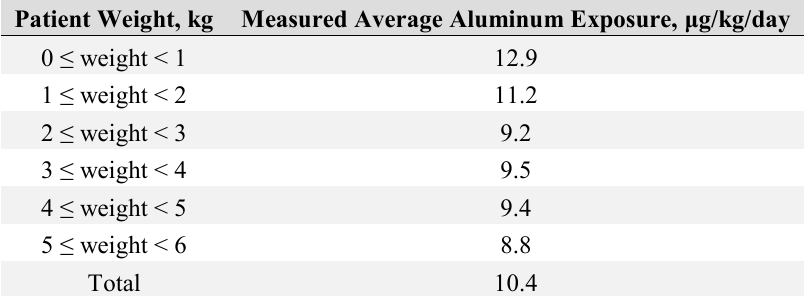
Table 5. Measured aluminum